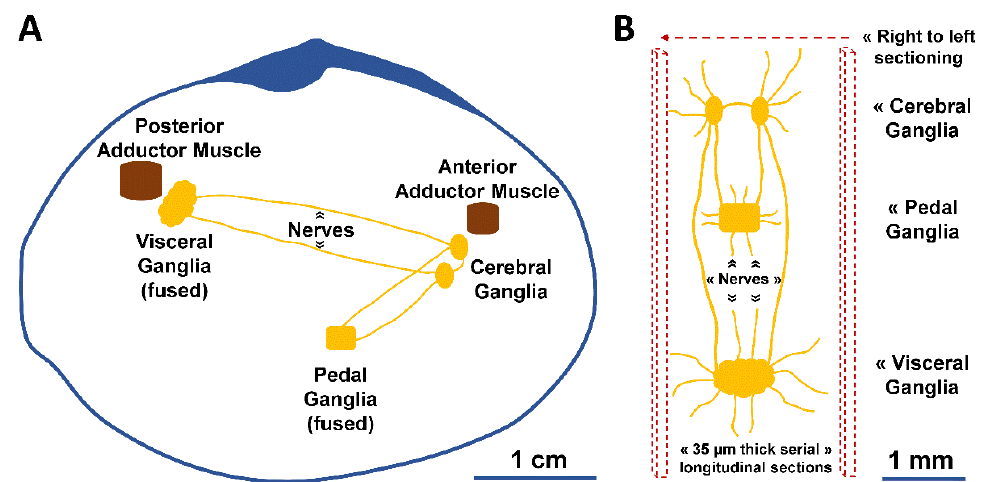
Figure 1. Schematic illustration of the nervous system of S. plana . ( A ) Longitudinal view of the right valve, depicting the right and left cerebral (cerebropleural) ganglia, pedal ganglia (fused in one), and visceral ganglia (fused in one). ( B ) Dorsal view of the ganglia, with inter-ganglionic connective nerves and others. The microtome serial sectioning was conducted longitudinally, from right to left.